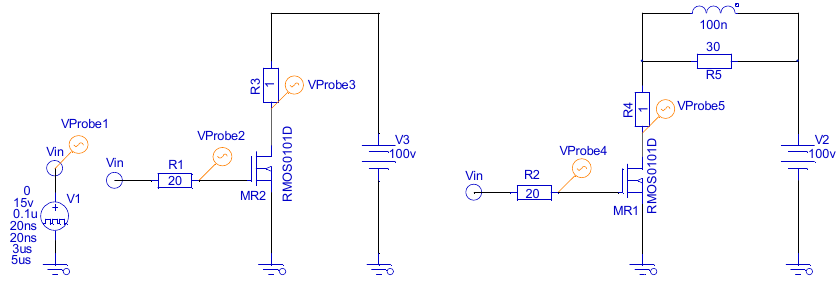
Figure 15. Simulation design for RMOS0101D with resistive and inductance loads.